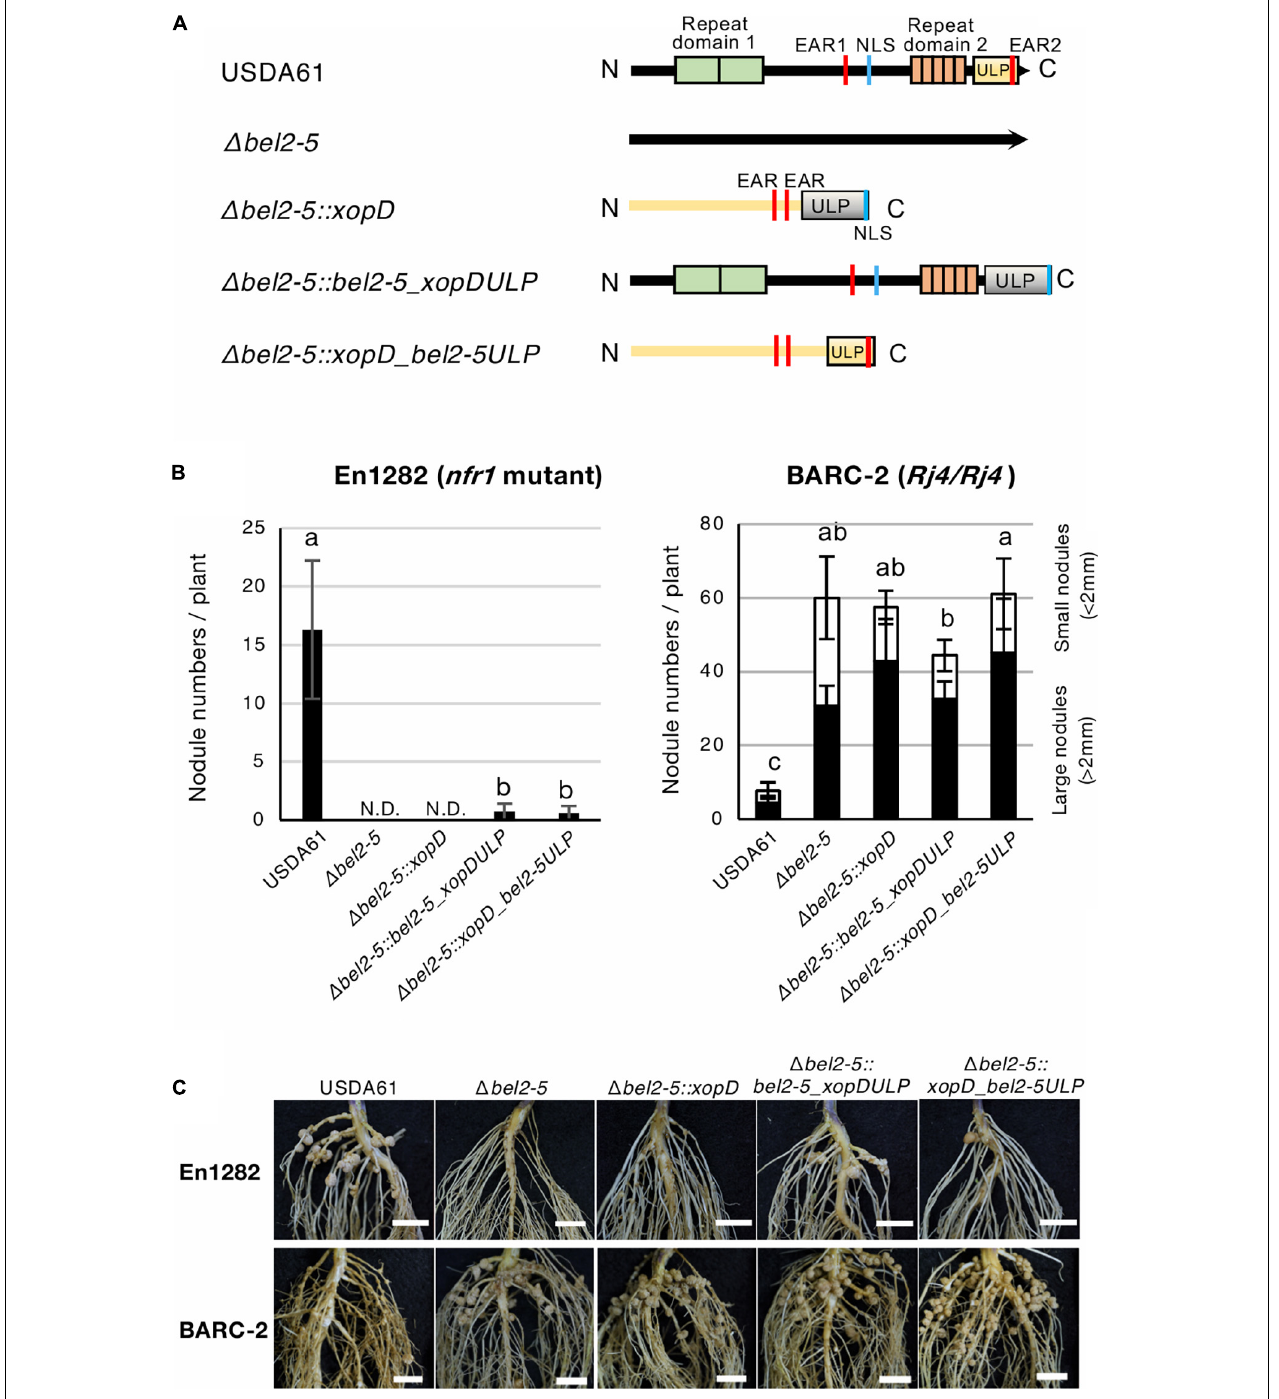
FIGURE 4 | Nodulation phenotypes of B. elkanii USDA61 wild-type and the bel2-5 deletion mutant and its derivatives carrying swapped regions of the ULP-like domain on soybean En1282 ( nfr1 mutant) and BARC-2 ( Rj4 / Rj4 ). (A) Schematic representation of swapping of the ULP-like domain between B. elkanii Bel2-5 and Xcv. XopD. (B) Nodulation of G. max cv. En1282 and BARC-2 inoculated with wild-type and mutant strains of B. elkanii USDA61. Nodule numbers were counted at 30 days after inoculation (dai). The values represent the mean ± SD ( n = 10 plants, from two independent inoculation tests). N.D., not detected. Means followed by different letters are significantly different at the 0.05 level by Tukey’s test. (C) Roots of En1282 and BARC-2 inoculated with wild-type and mutant strains of B. elkanii USDA61. Roots were photographed at 30 dai. Scale bars, 1 cm. USDA61, Bradyrhizobium elkanii wild-type; (cid:49) bel2-5 , bel2-5 knockout mutant; (cid:49) bel2-5:xopD , bel2-5 knockout mutant complemented with xopD ; (cid:49) bel2-5:bel2-5_xopDULP , bel2-5 knockout mutant complemented with bel2-5 harboring the ULP domain of xopD ; (cid:49) bel2-5:xopD_bel2-5ULP , bel2-5 knockout mutant complemented with xopD harboring the ULP domain of bel2-5 .